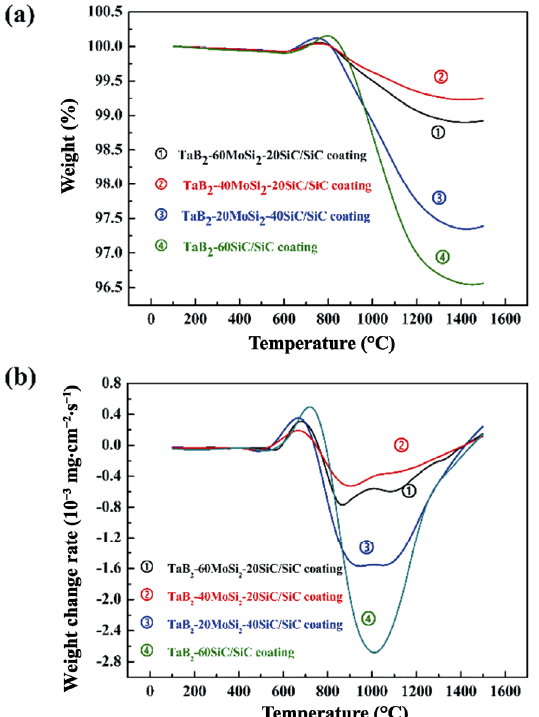
Fig. 12 (a) TGA curves of the samples with different MoSi 2 contents or TaB 2 contents; (b) weight change rate curves of the samples with different MoSi 2 contents or